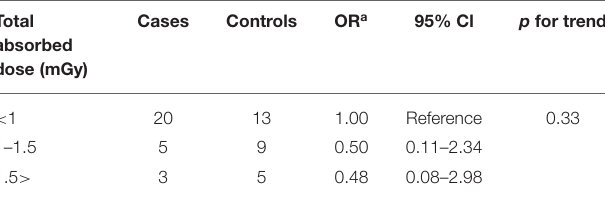
TABLE 4-1 | Distribution of subjects and OR s for lung cancer according to estimated radon, thoron absorbed dose (Using dose conversion factor derived from UNSCEAR).